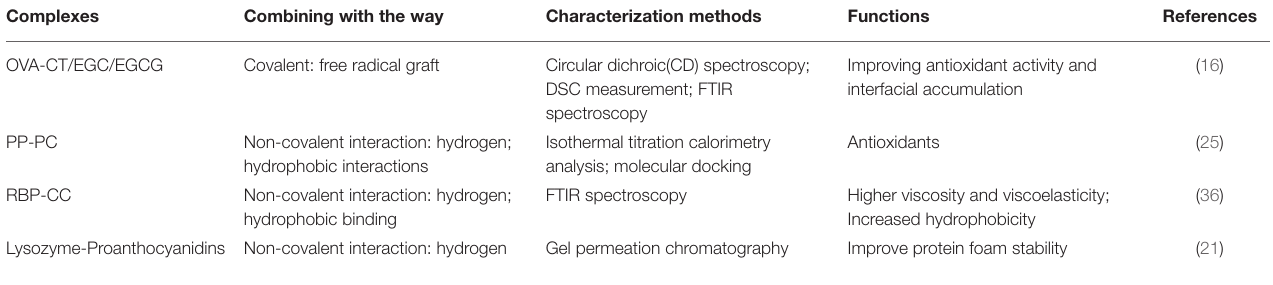
TABLE 2 | Typical plant and microbial protein-polyphenol complexes.